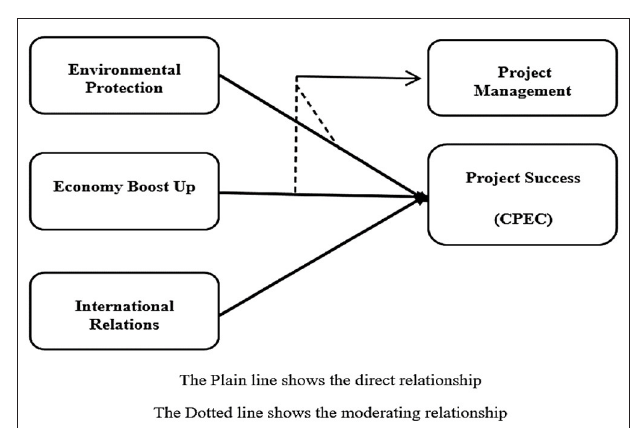
FIGURE 2 | The study